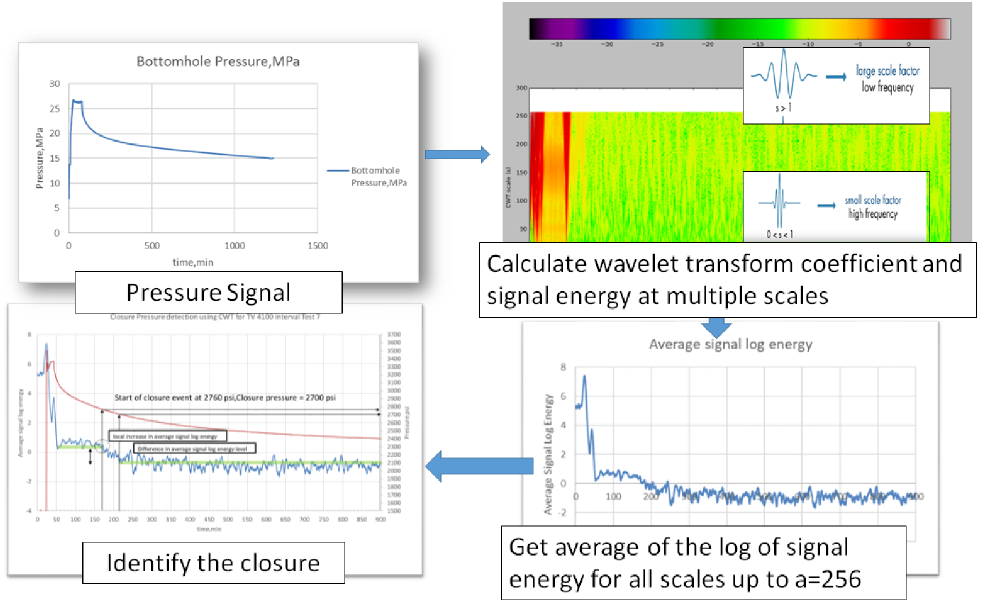
Figure 5. Fracture closure detection workflow using the CWT closure detection technique.